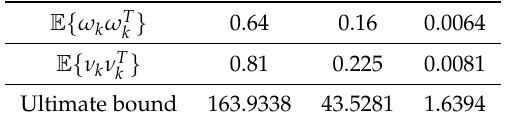
Table 1. The effects of the noise covariances on the ultimate